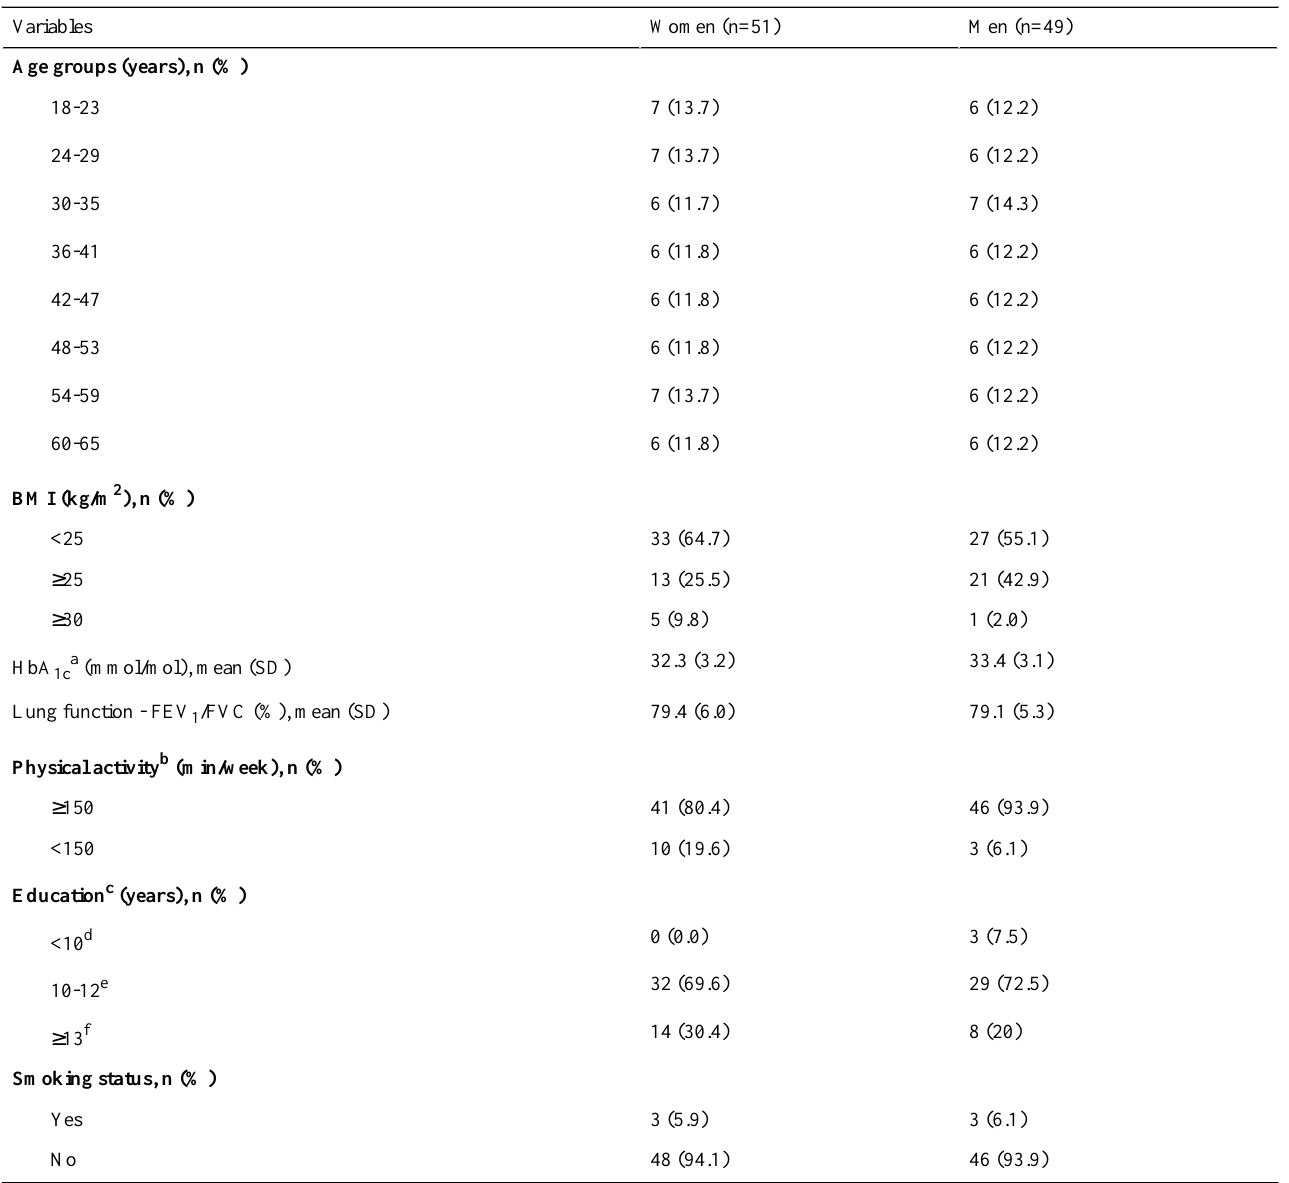
Table 1. Characteristics of study participants in the derivation